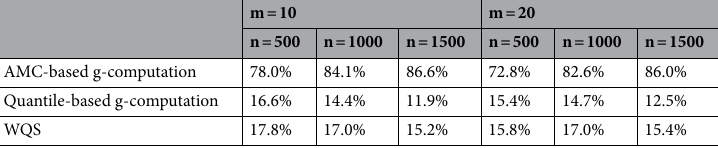
Table 2. Average True Positive Rates (TPRs) of the three methods under non-monotonic effects. Average TPR was calculated across 1000 simulations; m was the number of exposures; n was the sample size.